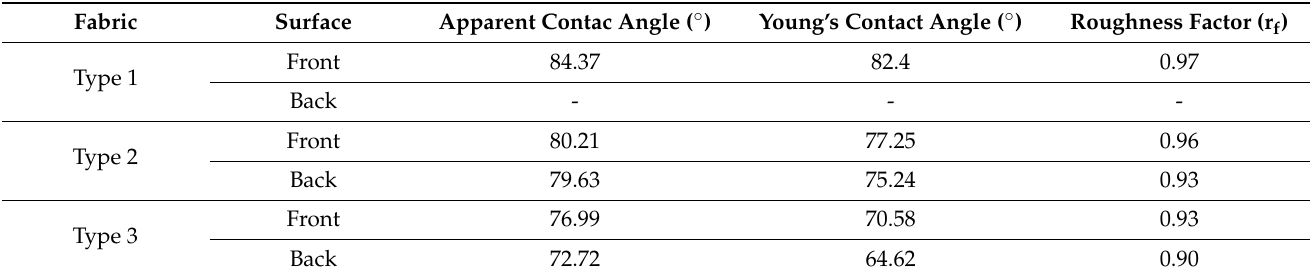
Table 1. Surface roughness factor of top and bottom surface of Type 1, Type 2, and Type 3 fabrics estimated from contact angle (with water)